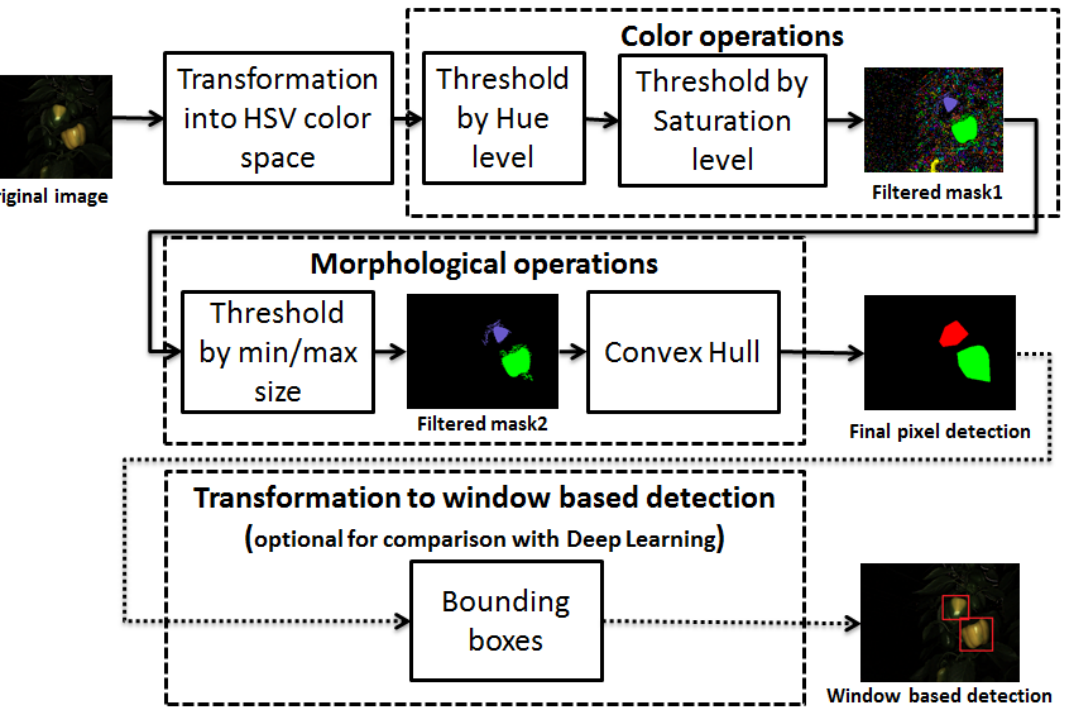
Figure 3. Color-based algorithm flowchart. The additional transformation from pixel-based detection to window-based detection is made for comparison with the deep learning